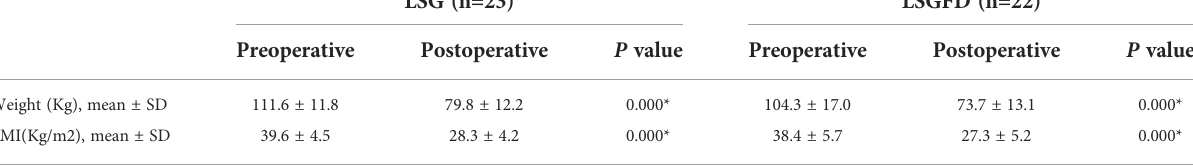
TABLE 3 Comparison of preoperative and postoperative weight related evaluation after LSG and